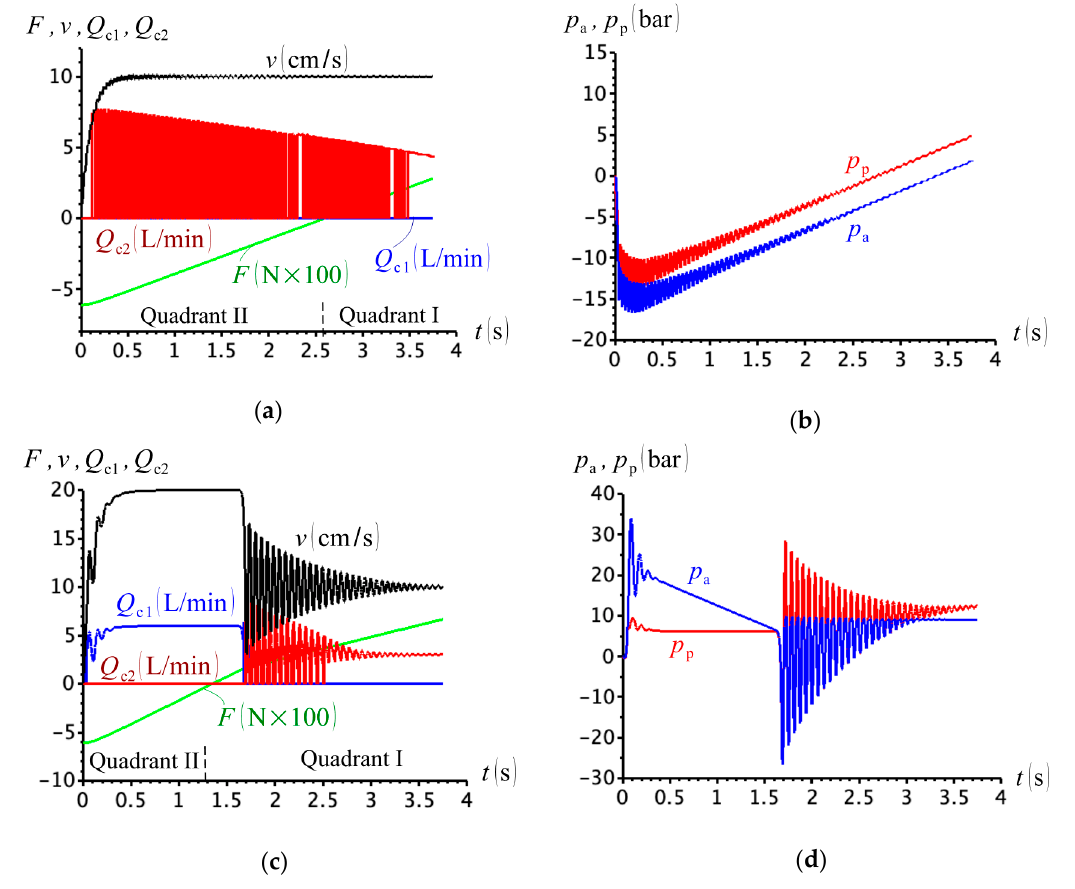
Figure 23. ( a ) External force, cylinder velocity and compensation flows ( p cr = 3 bar); ( b ) cap- and rod-